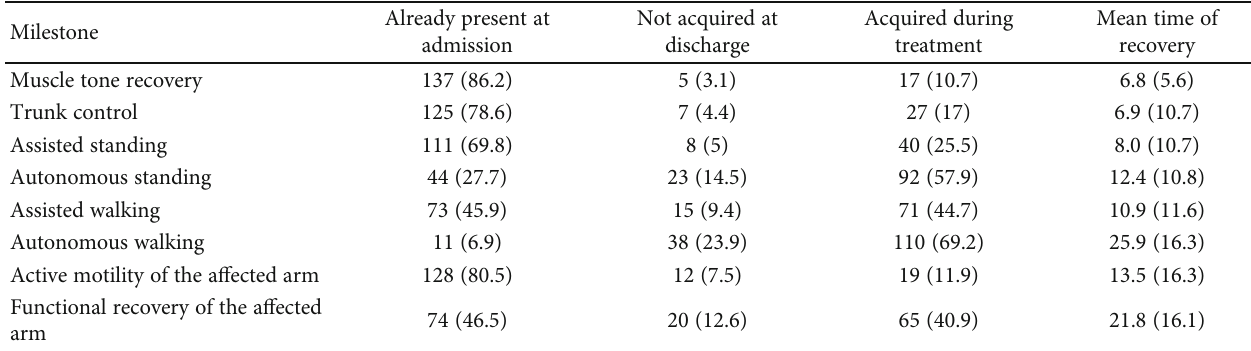
Table 2: Number (and %) of patients who reached the recovery milestones during the observation period and mean days (and SD) elapsed after admission for recovery of each milestone (data available for 159/176